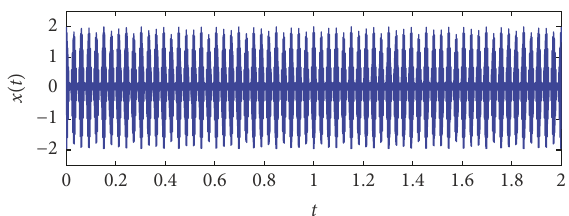
Figure 2: The simulated gear vibration signal without noise.